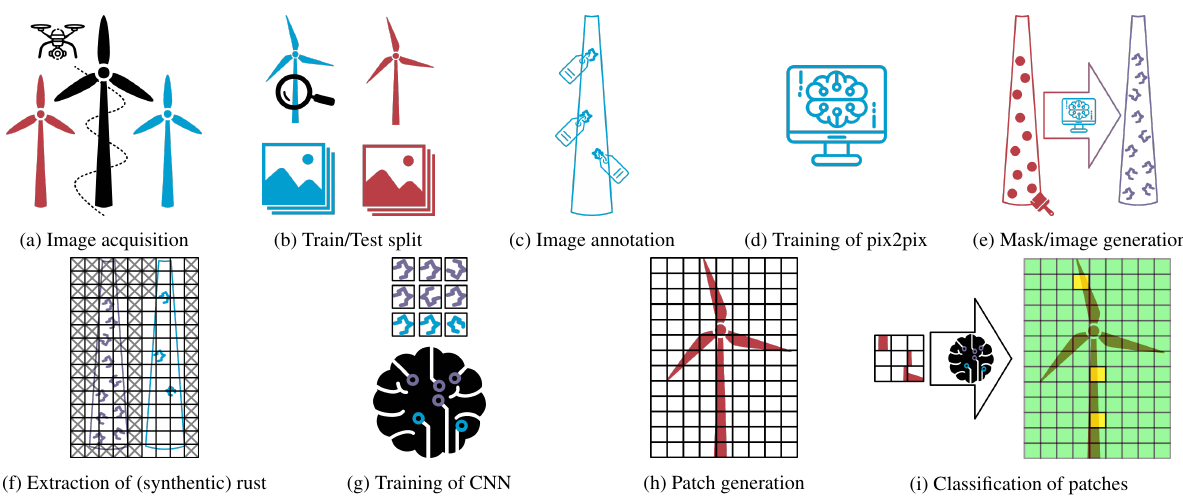
Figure 1. Experiment overview: We show the different steps of our experimental setup. The upper row a)-e) shows the generation of synthentic data samples using GANs. The lower row f)-i) shows the patch classification experiment used for validation of our method. More information concernig each step is provided in the text (cmp. section 2). Training data and derived data and models are colored blue, test data are colored red and synthetic data are colored